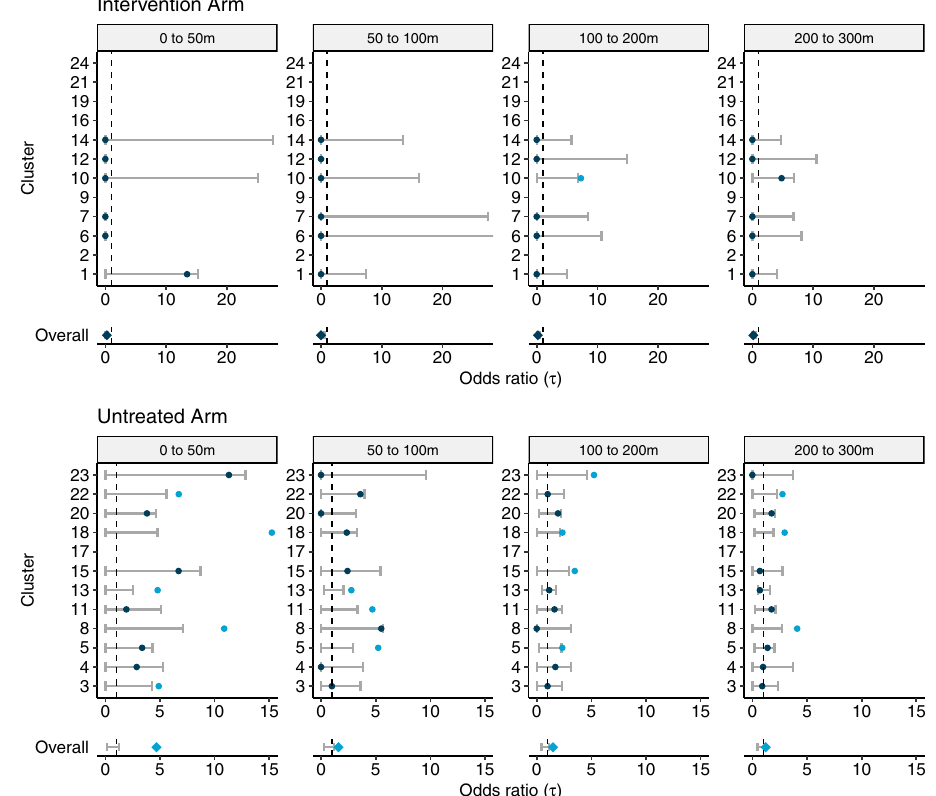
Figure 4. Cluster-specific and pooled arm-level estimates of the τ -statistic (points) and 95% CIs on the null distribution (error bar) generated from 1000 simulations where the geolocation of participants is randomly permuted within each cluster. Each panel displays the estimated spatial dependence for homotypic case pairs with illness onset occurring within 30 days and resident within a given distance interval (meters) from each other. Estimated spatial dependence that is inconsistent with the null hypothesis is present when the point estimate falls outside of the 95% CIs of the null distribution and, for improved visibility, is marked by the light blue points. The overall point estimate for each trial arm is found by taking the geometric mean of the cluster- level estimates and is then compared against the 95% CIs of the null distribution of the permuted geometric